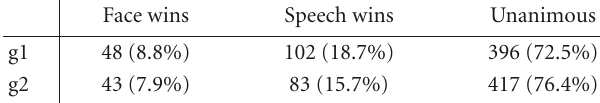
Table 5: Agreement